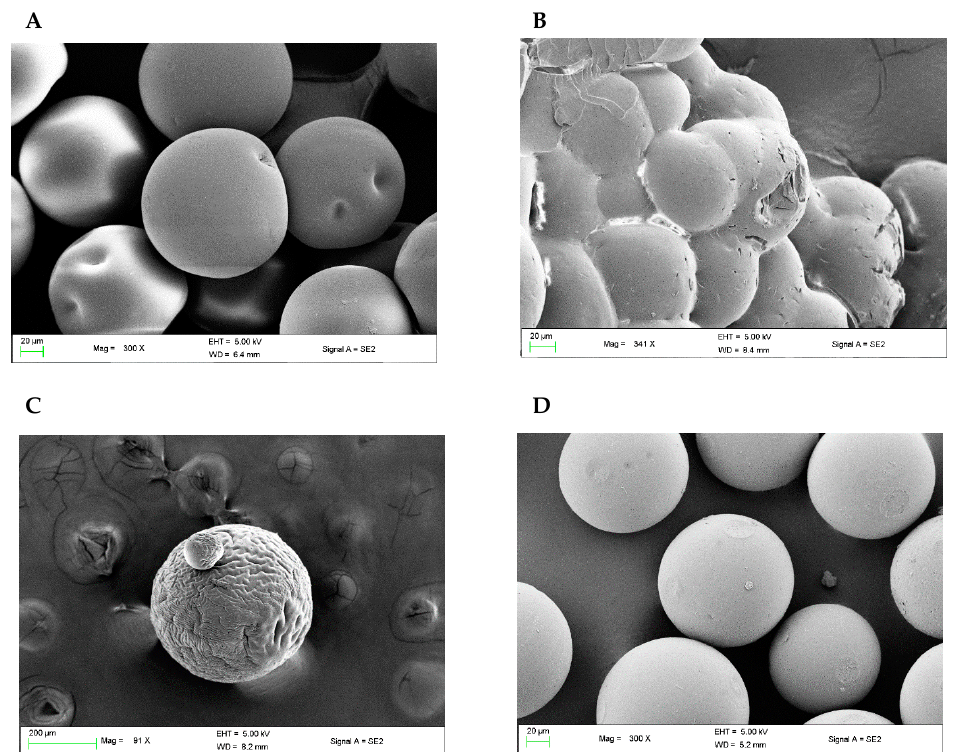
Figure 3. Scanning electron microscope (SEM) images of 2-chlorotrityl chloride (CTC) resin: ( A ) diethyl ether (DEE) (dimples); ( B ) tert-butyl methyl ether (MTBE) (fracture); ( C ) 2-methyltetrahydrofuran (2-MeTHF) (dented tracks); and, ( D ) cyclopentyl methyl ether (CPME) (intact).